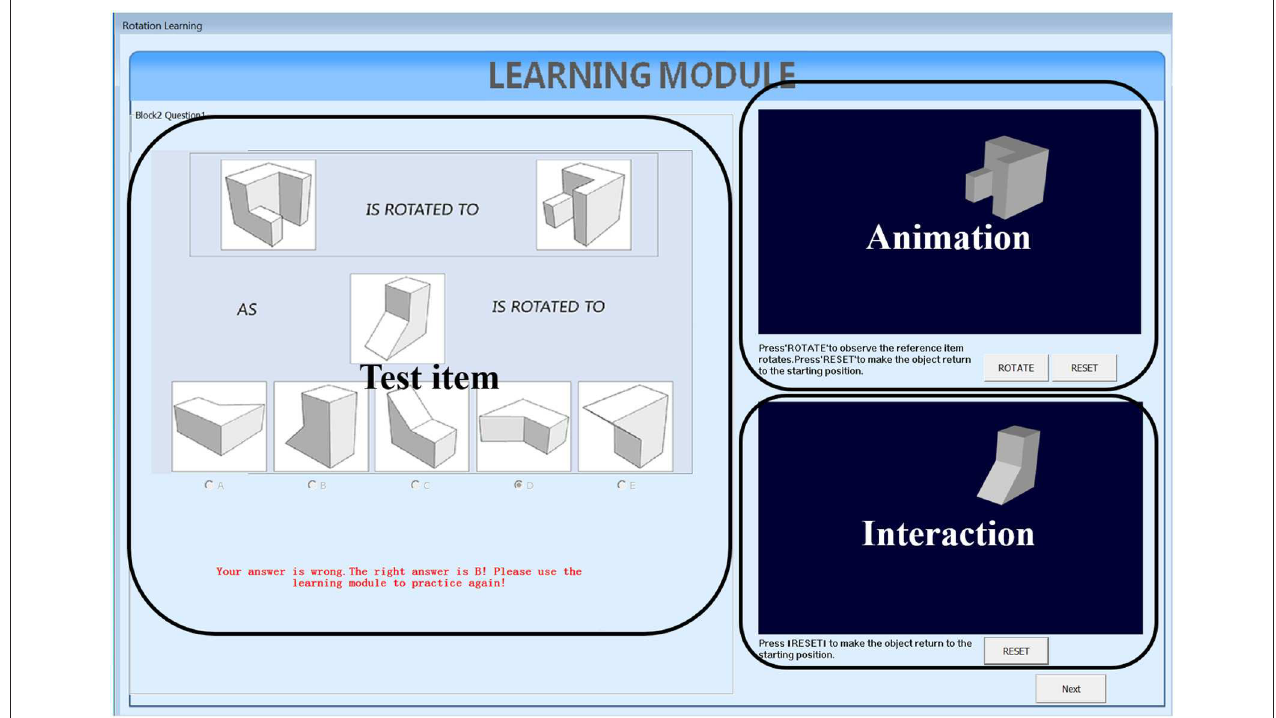
FIGURE 3 | Non-colored